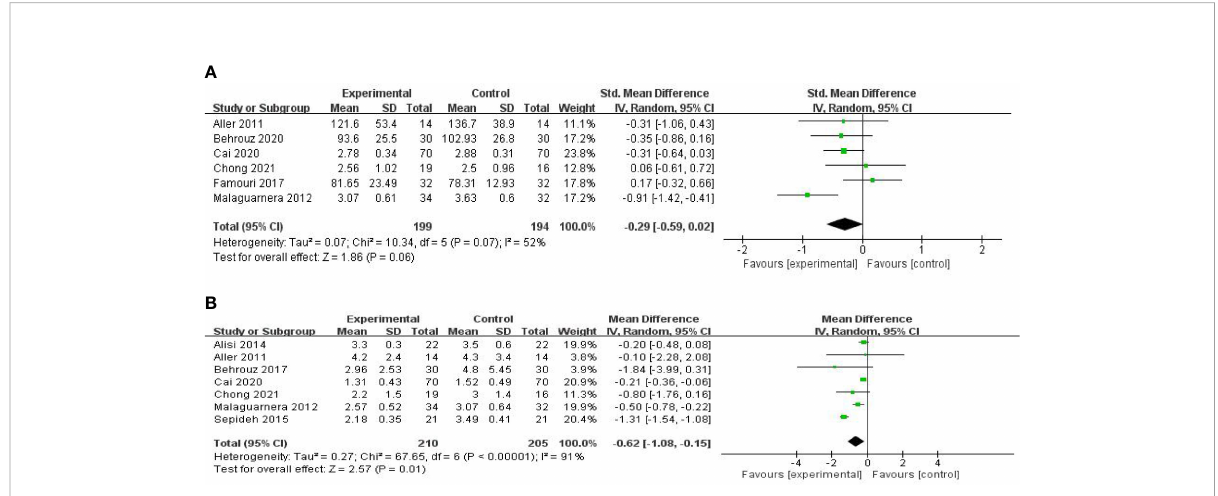
FIGURE 6 Forest plot of the effect of probiotic supplementation on LDL-C (A) . Forest plot of the effect of probiotic supplementation on HOMA-IR (B) .